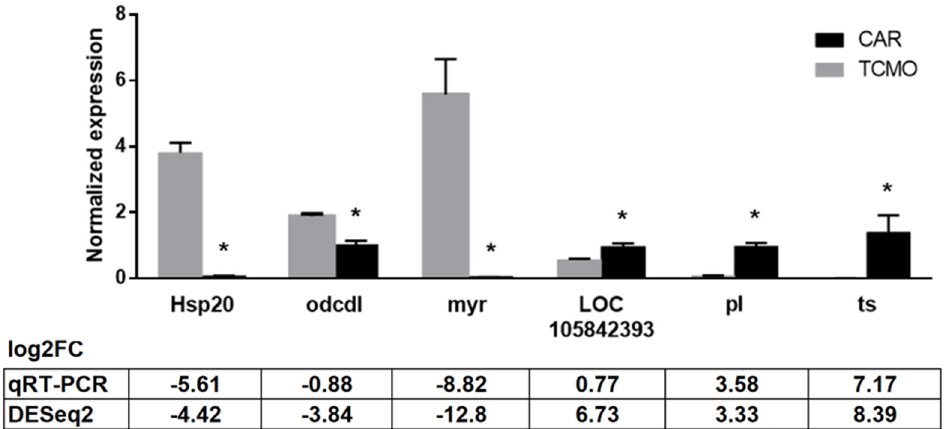
Figure 8. Results of qPCR validation of differentially expressed genes. Heat shock protein 20 (Hsp20), oxygen-dependent choline dehydrogenase-like (odcdl), and myrosinase 1 (myr) were downregulated in CAR vs. TCMO, while uncharacterized protein (LOC105842393), peroxidase-like (pl), and uncharacterized protein tetraspanin family (ts) were upregulated in CAR vs. TCMO. Log 2 FC values calculated from qPCR results are compared with values obtained during DESeq2 analysis. Error bars indicate standard deviation; asterisks denote significant change in CAR vs. TCMO (Student’s t-test), p < 0.05.